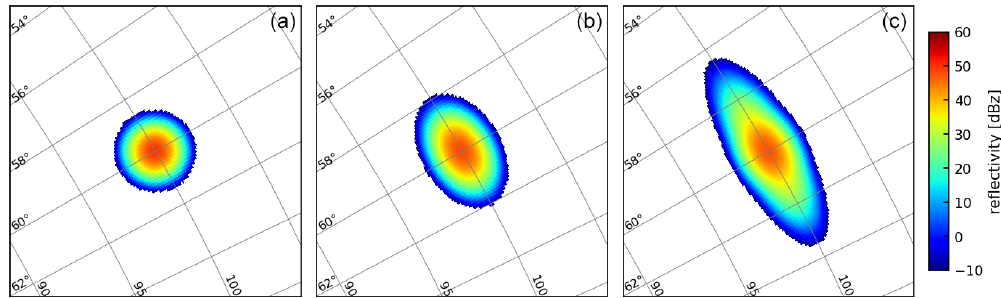
Figure A2. Simulated effect of broadening of a circular rain cell when observed by a radar. (a) Simulated rain cell; (b) observed with a radar with beamwidth 1 ◦ ; (c) as center image, but with Poldirad beam. Range rings are shown every 5km and radials every 2 ◦ .